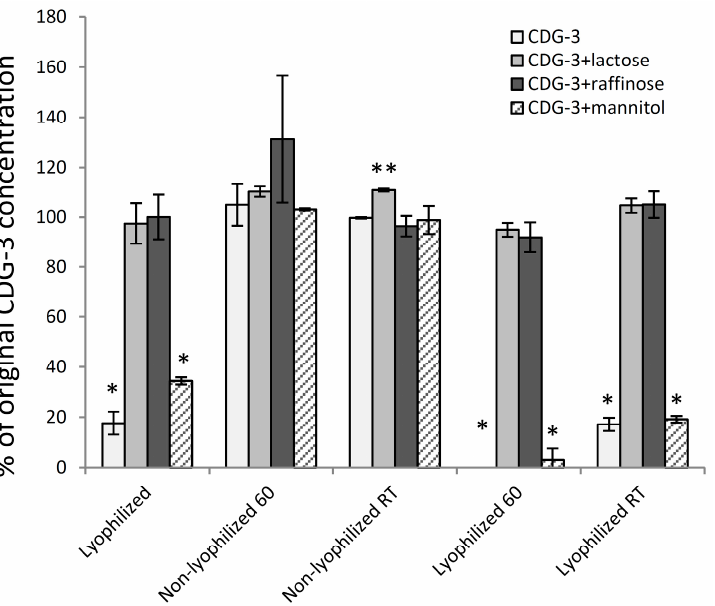
Figure 5. Lyophilization excipients demonstrate differing protection from high temperature. Result of HPLC analysis of the substrate after lyophilization and exposure to various experimental conditions shown. Ratios of HPLC peak areas of the substrate after exposure to experimental conditions and unexposed substrate were determined. These data suggest that combinations of excipient sugars may further improve CDG-3 reagent stability at elevated temperature following reconstitution. Two experimental replicates for each condition. Error bars represent the standard deviation. * different from lactose and raffinose ( p < 0.01); ** different from raffinose ( p < 0.05).